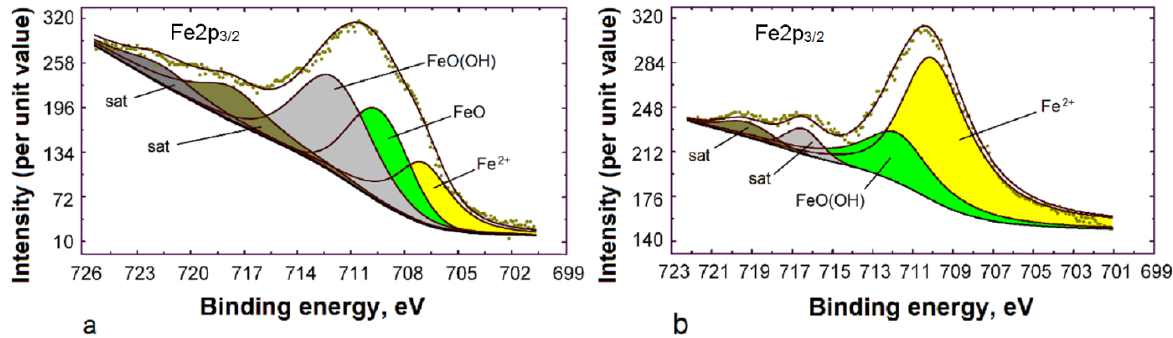
Figure 5. Fe2p 3/2 spectra of steel at different exposure times in a hydrophobic inhibitor solution: ( a ) 10 min; ( b ) 60